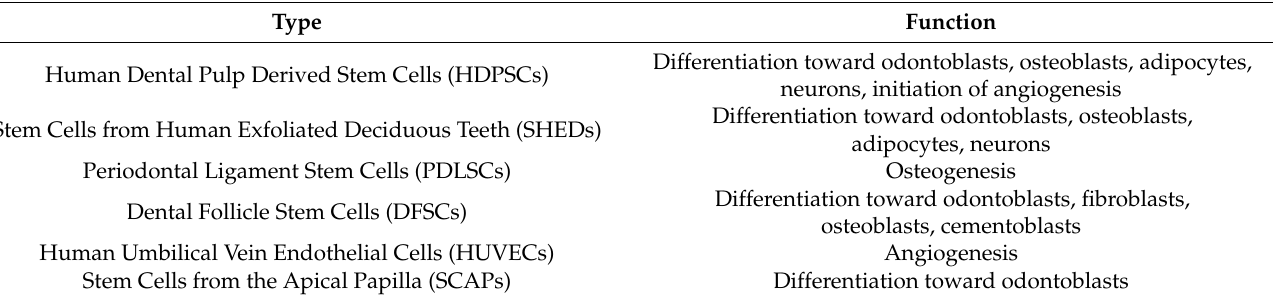
Table 1. Stem cells involved in apexogenesis and REP.